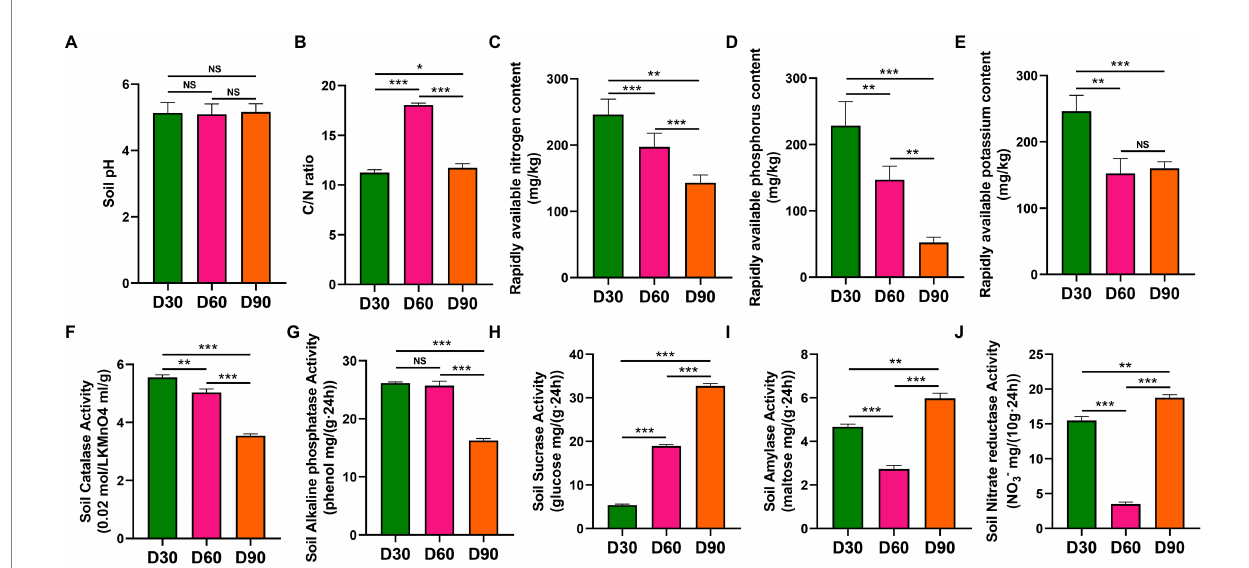
FIGURE 1 Physicochemical properties of rhizosphere soil of flue-cured tobacco at different transplantation stages. (A) . pH of rhizosphere soil of the flue-cured tobacco. (B) . C/N ratio of rhizosphere soil of the flue-cured tobacco. (C) . Rapidly available nitrogen content of rhizosphere soil of the flue-cured tobacco. (D) . Rapidly available phosphorus content of rhizosphere soil of the flue-cured tobacco. (E) . Rapidly available potassium content of rhizosphere soil of the flue-cured tobacco. (F) . Catalase activity of rhizosphere soil of flue-cured tobacco. (G) . Alkaline phosphatase activity of rhizosphere soil of flue-cured tobacco. (H) . Sucrase activity of rhizosphere soil of flue-cured tobacco. (I) . Amylase activity of rhizosphere soil of flue- cured tobacco. (J) . Nitrate reductase activity of rhizosphere soil of the flue-cured tobacco.